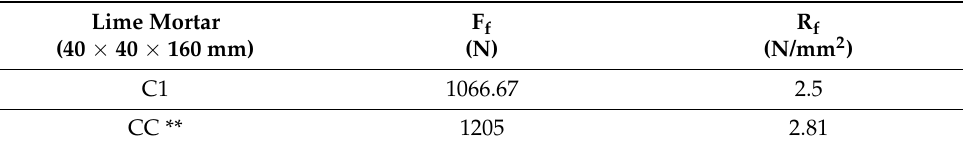
Table 9. Flexural strength test: lime mortar specimens treated with MYXOSTONE M3P (mean values). Lime Mortar